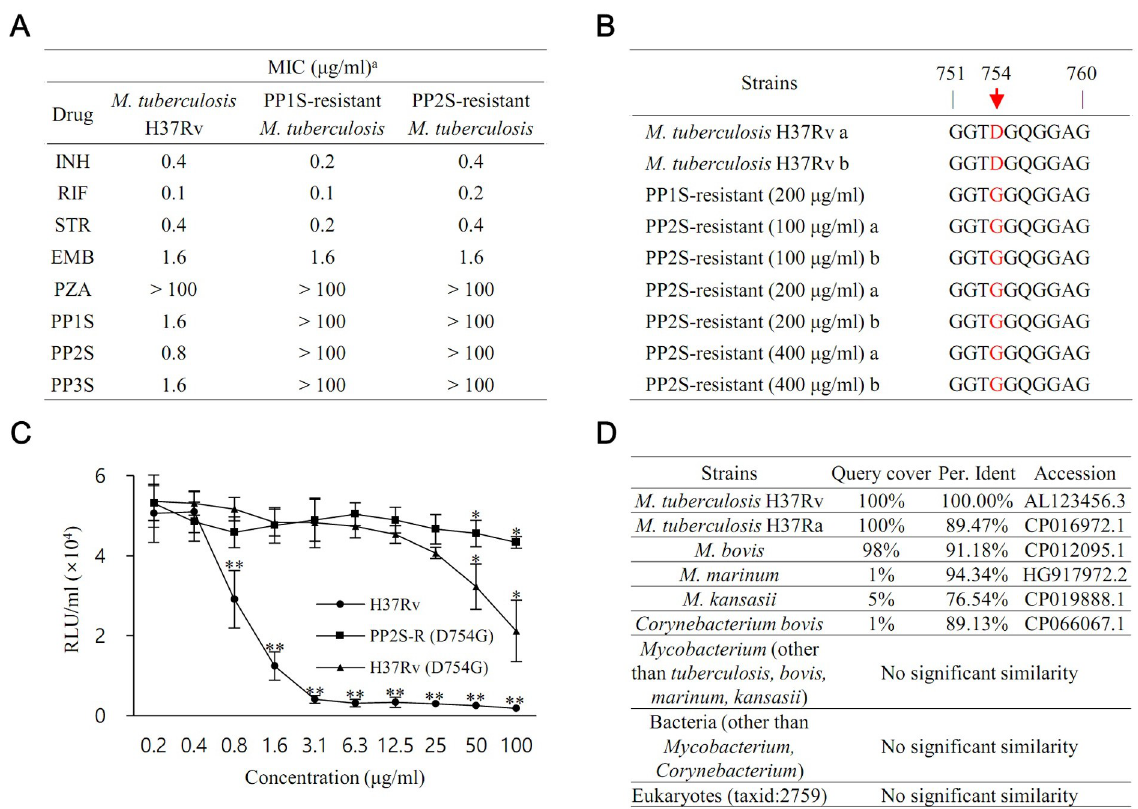
Fig 7. Identification of PPs target. (A) PPs-resistant M . tuberculosis strains were prepared, and resistance was verified by a resazurin microtiter assay. (B) As a result of whole-genome sequencing analysis of resistant strains, it was confirmed that the sequence encoding the 754th amino acid of Rv3514 was commonly mutated. (C) It was confirmed that resistance to PPs occurs when the H37Rv strain is artificially induced through point mutagenesis. (D) As a result of NCBI Nucleotide BLAST analysis of the sequence of Rv3514 , it was confirmed that the similarity was low or absent except for the M . tuberculosis complex. Data are expressed as mean ± SD. Statistical significance with initial value was analyzed using unpaired Student t test. � , p < 0.05; �� , p < 0.01. BLAST, Basic Local Alignment Search Tool; EMB, ethambutol; INH, isoniazid; NCBI, National Center for Biotechnology Information; PP, methyl (S)-1-((3-alkoxy-6,7-dimethoxyphenanthren-9-yl)methyl)- 5-oxopyrrolidine-2-carboxylate; PZA, pyrazinamide; RIF, rifampicin; STR, streptomycin. Data underlying this Figure can be found in S1 Data.